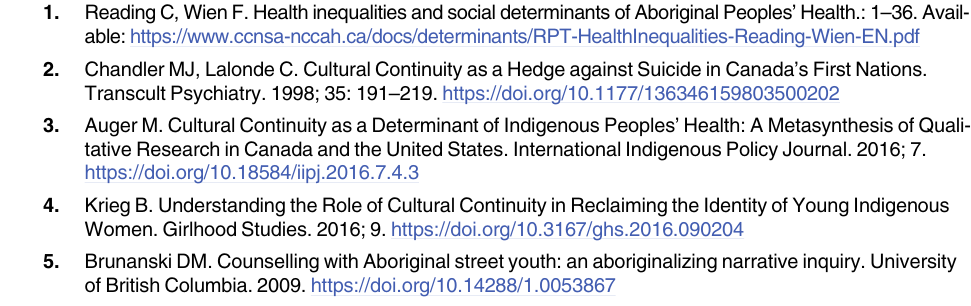
S1 Table. Counted quotations of each theme and subtheme. S2 Table. Age of study